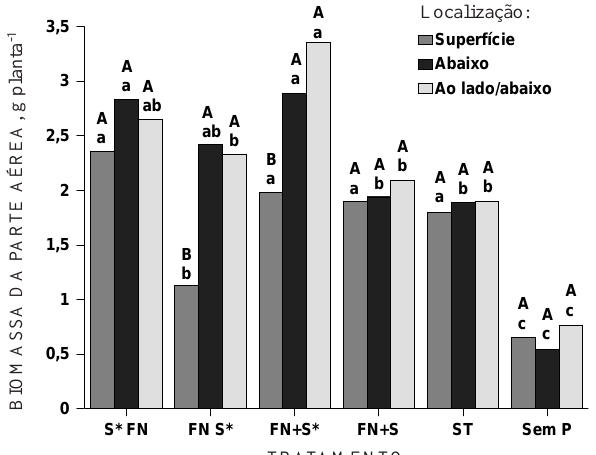
Figura 3. Biomassa seca da parte aérea do jacatupé nos tratamentos FN revestindo o enxofre inoculado com Acidithiobacillus (FN S*), FN revestido com S inoculado com Acidithiobacillus (S* FN), mistura FN com S inoculado com Acidithiobacillus (FN + S*), mistura FN com S sem Acidithiobacillus (FN + S), superfosfato triplo (ST) e sem adição de fósforo (sem P) de acordo com a localização do adubo. Letras minúsculas comparam as médias dos diferentes tratamentos com adição de P em cada modo de localização do adubo; as maiúsculas, cada tratamento com P nos diferentes modos de localização do adubo. C.V. % = 4,55.